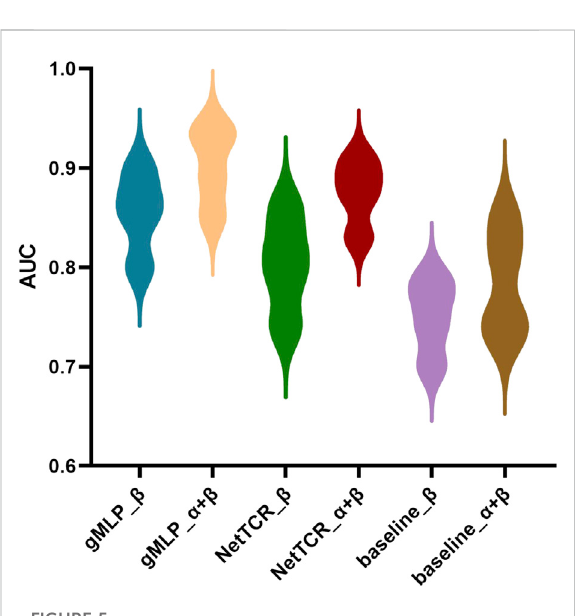
FIGURE 5 Comparison of the overall AUC obtained from gMLP, baseline, and NetTCR on data containing only ß -chains and data containing paired a -and ß -chains,